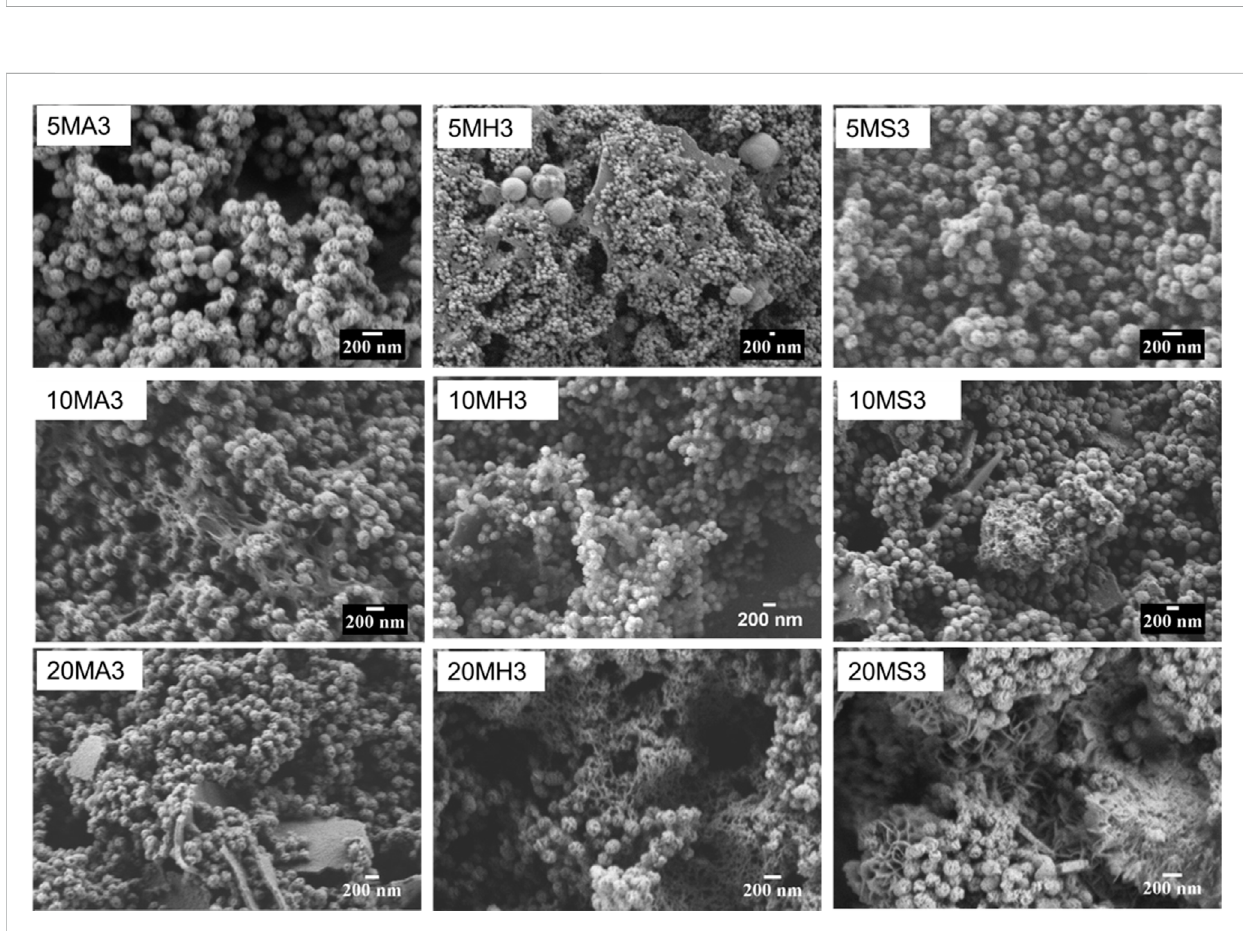
FIGURE 6 SEM micrographs of the doped MBGNs arranged in rows as 5LiMBGNs (top), 10LiMBGNs (middle) and 20LiMBGNs (bottom) at day 3 of immersion. The micrographs are arranged from right to left based on immersion fl uid AS (left), HBSS (middle) and SBF (right).